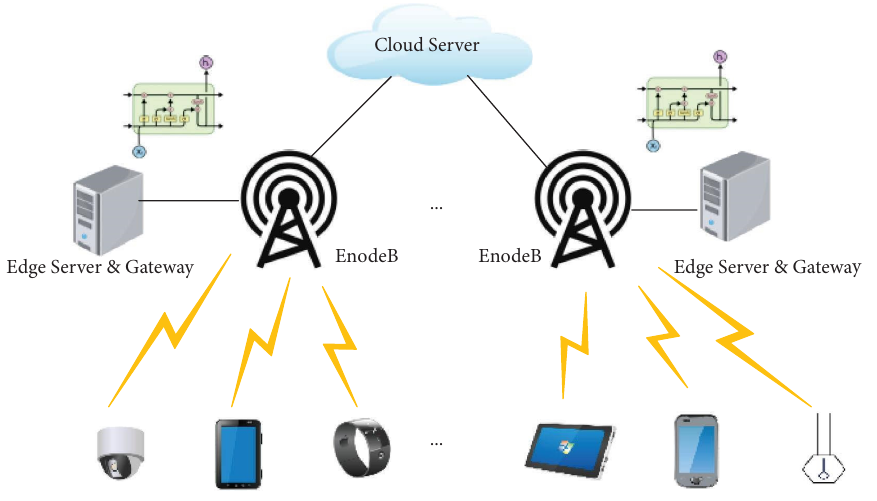
Figure 1: Trafc prediction for 6G MEC